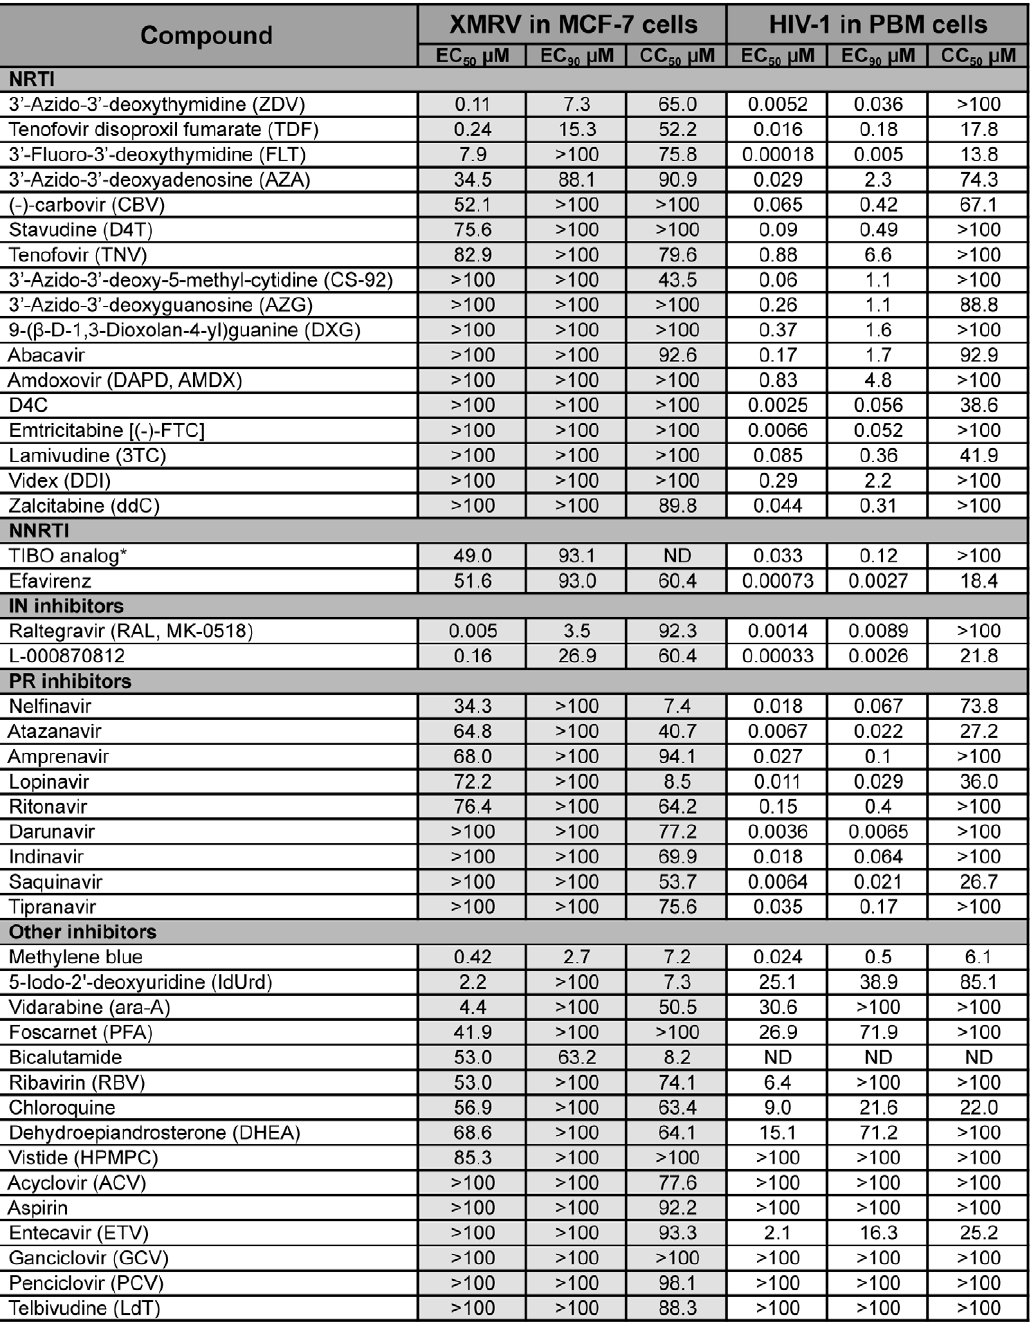
Figure 1. EC 50 , EC 90 and CC 50 values of compounds tested in XMRV-infected MCF-7 cells, and in HIV-1 infected peripheral blood mononuclear cells. All compounds were evaluated in duplicate at least three times. Values shown are average of replicate assays. *(4 S )-8-Chloro-4- methyl-5-(3-methylbut-2-enyl)-3,4,5,6-tetrahydro-1H-[1,3]diazepino[4,5,6-cd]indole-2(2aH)-thione.